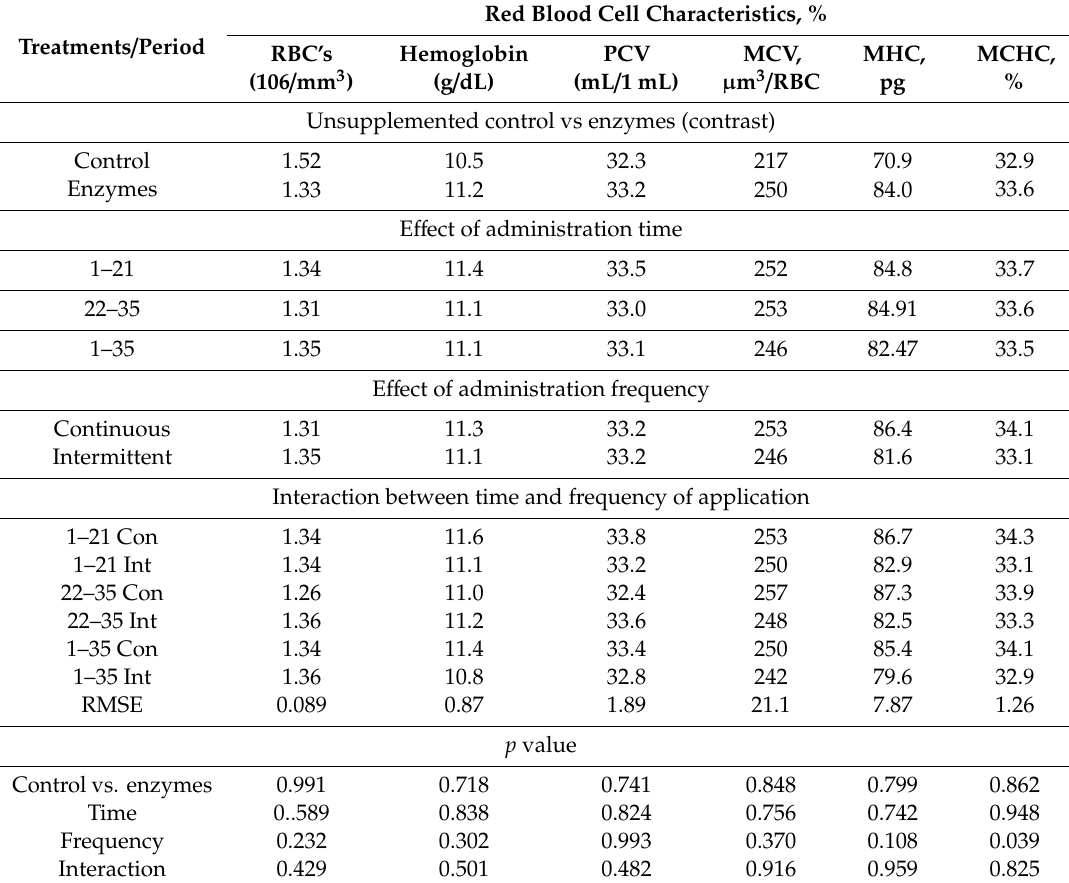
Table 6. E ff ect of multienzymes supplemented in water continuously or intermittently during the starter, grower and the complete times on red blood cell characteristics in broiler chicks. Red Blood Cell Characteristics, % Treatments / Period Unsupplemented control vs enzymes (contrast)